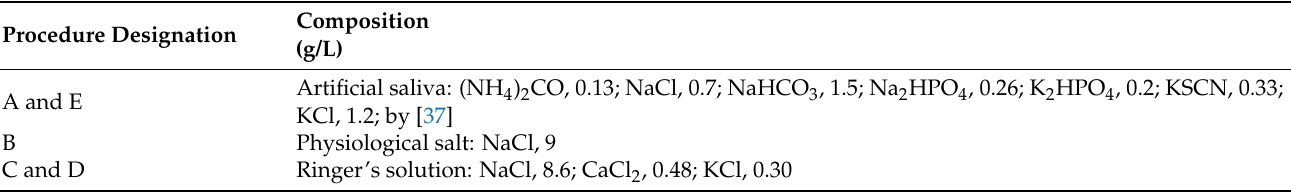
Table 3. Chemical compositions of simulated body fluids used in various